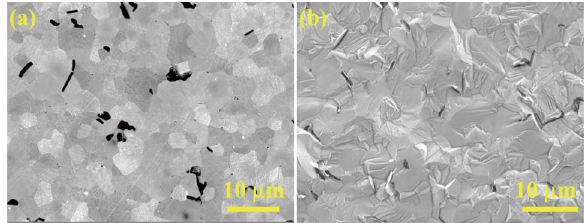
Fig. 6 SEM images of (a) polished surface and (b) fracture surface of the ht-HEC9-5C